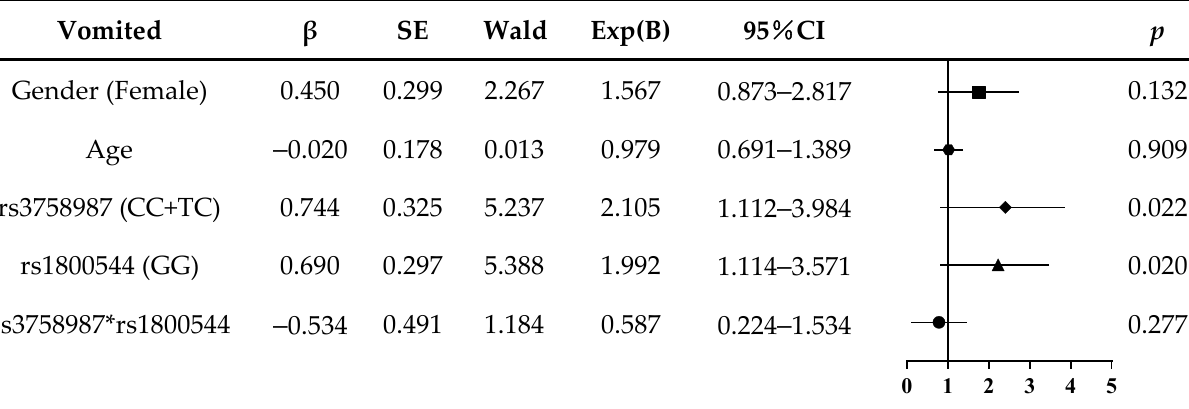
Figure 2. Logistic regression analysis of risk of motion sickness induced-vomiting in subjects.